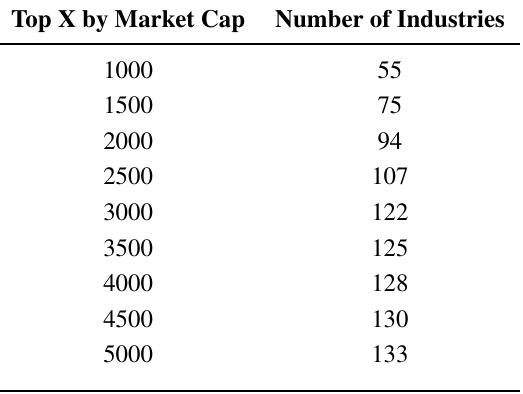
Table 6. Number of BICS industries for portfolios of stocks in top X by market cap with at least 10 stocks in each industry as of August 19, 2014. Only U.S. listed common stocks and class shares are included (no OTCs, preferred shares,